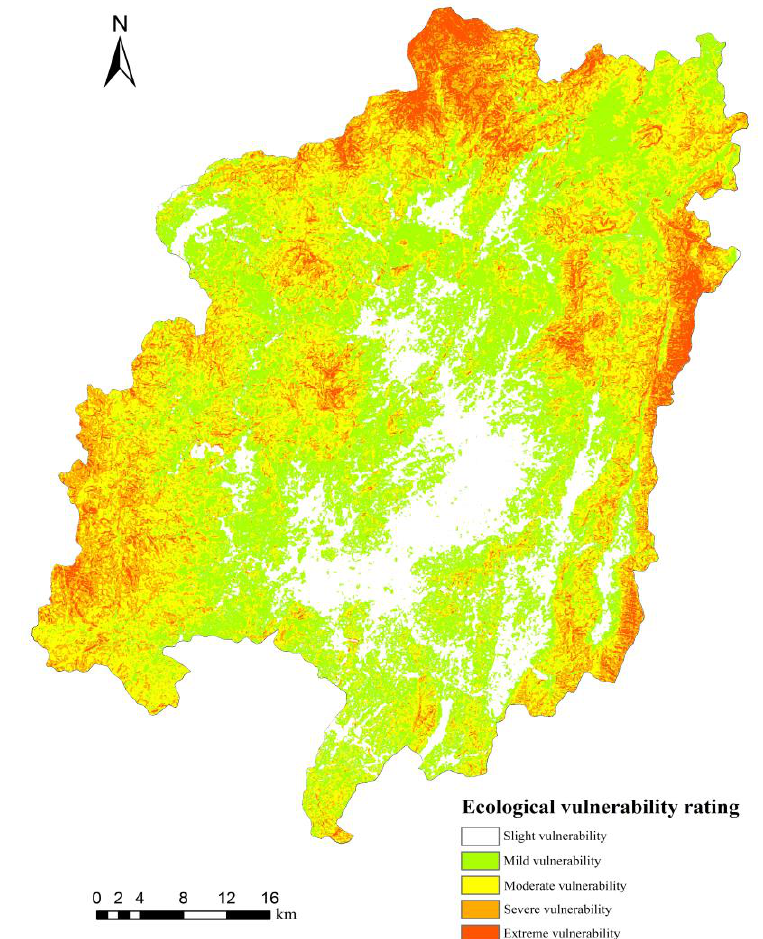
Figure 6. Prediction map of ecological vulnerability in red soil erosion area of Changting.